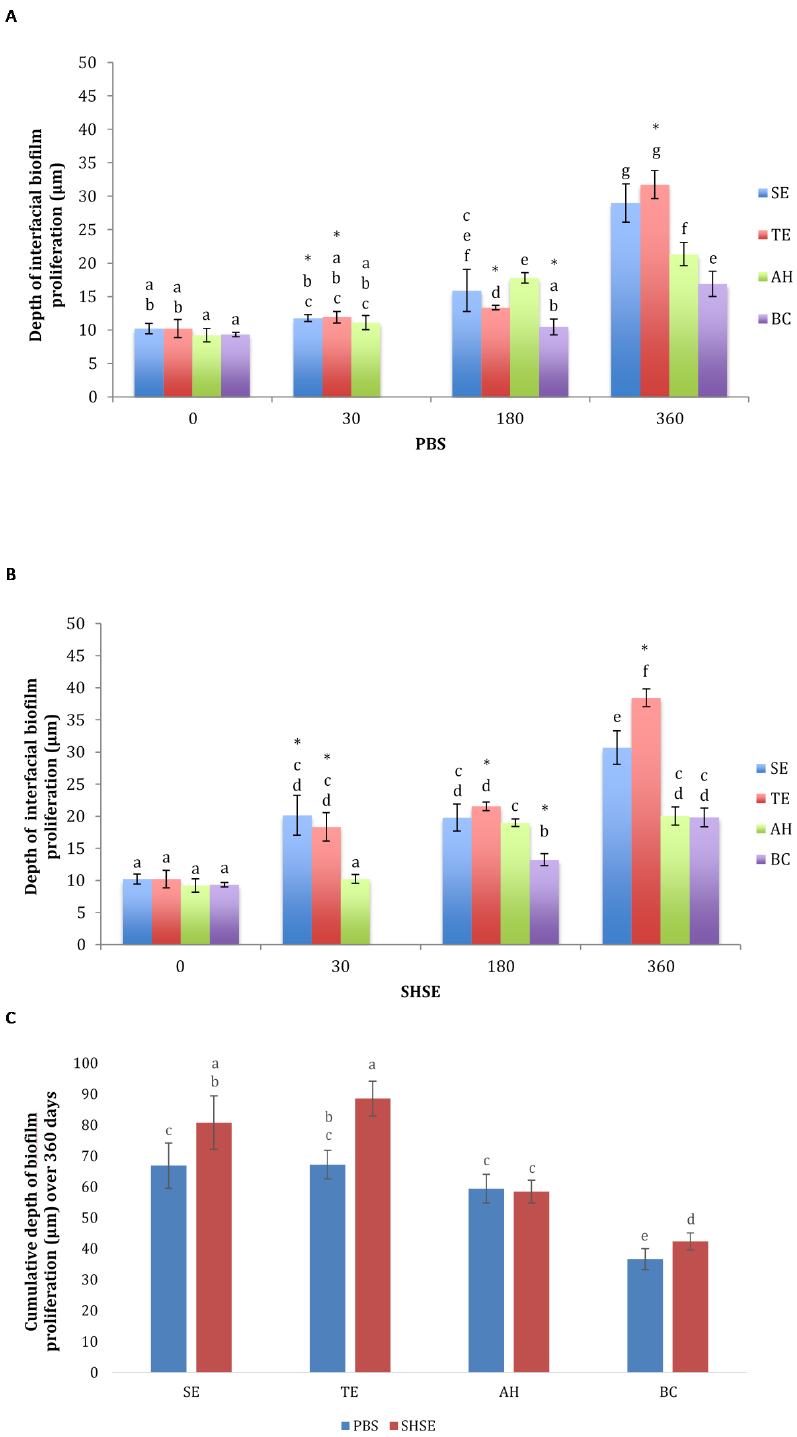
Figure 2. Interfacial biofilm proliferation depth ( µ m) for the test groups (SE, self-etch adhesive; TE, total-etch adhesive; AH, epoxy-resin sealer; BC, bioceramic sealer) before and after aging for 30, 180 and 360 days in either ( A ) PBS or ( B ) SHSE. ( C ) Maximum depth of biofilm proliferation ( µ m) for all aging periods in either PBS or SHSE for each test material group. Data are shown as mean ± SD. BC had the lowest bacterial penetration ( C ). Different letters represent statistically significant differences between materials at different aging periods within the same aging medium. * Indicates significant difference between PBS and SHSE for the same material at same aging period.